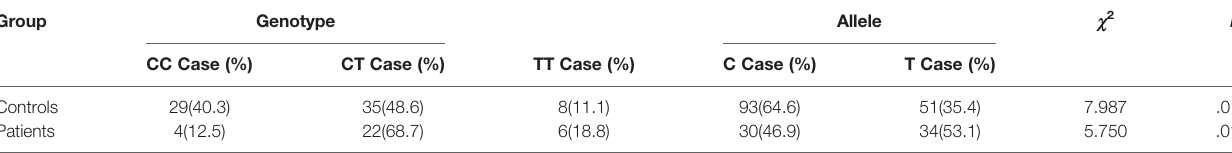
TABLE 5 | The chi-square test of MTHFR C667T genotypes and allele distribution.